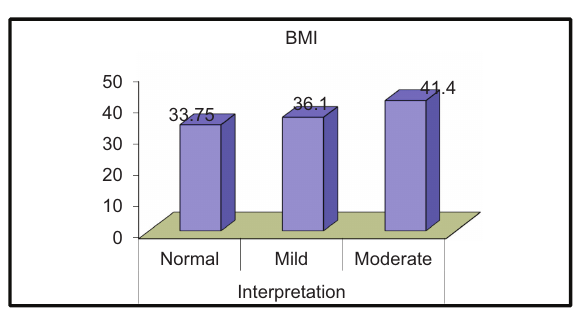
Rela(cid:2)on between BMI in obese persons and degree of restric(cid:2)ve pa(cid:3)ern Relation between BMI and degree of restrictive spirometric pattern in obese persons.